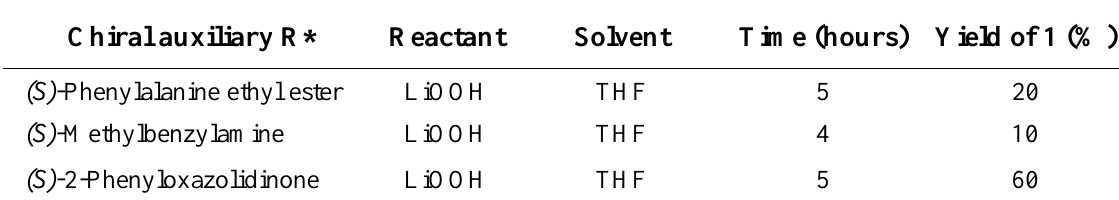
Table 2 . The hydrolysis of thomasidioic acid